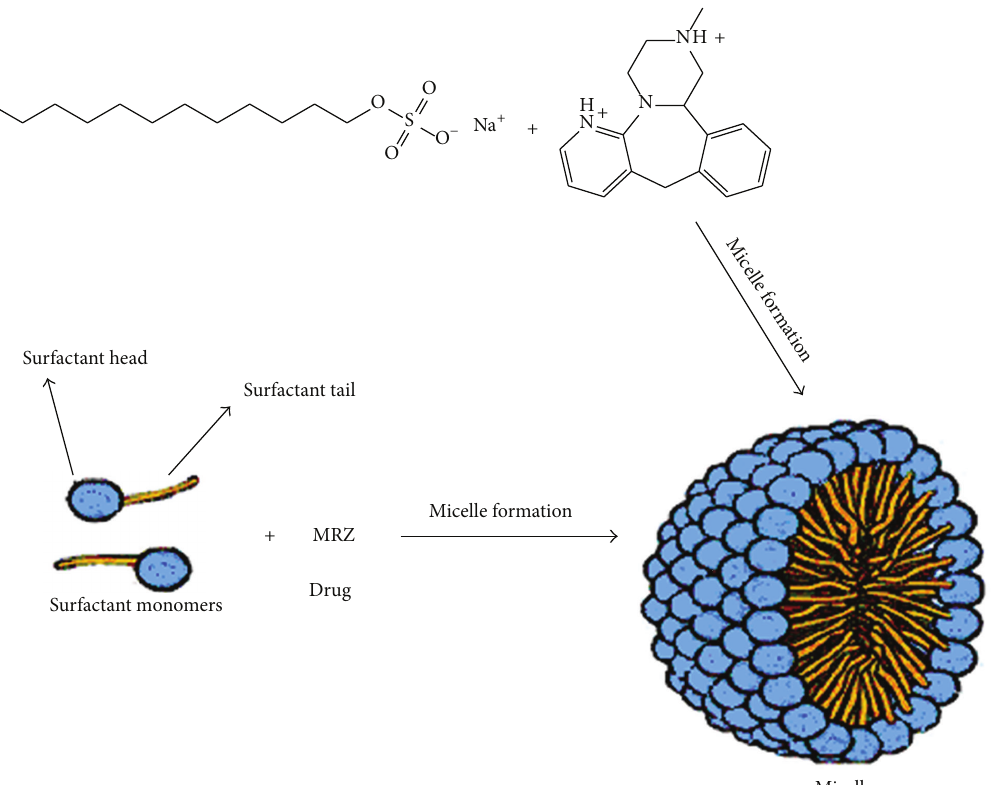
Scheme 1: The suggested mechanism for CRZ-SLS micelle formation.